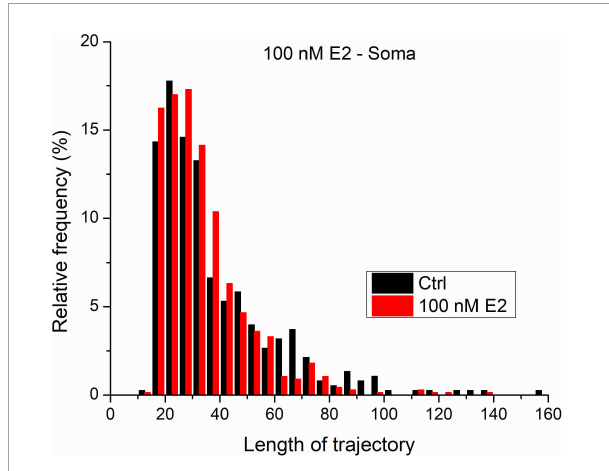
FIGURE6 The trajectories length distribution from GluR2-AMPAR molecules in the soma’s plasma membranes of dPC12, live-cell in control state and after administration of 100 nM